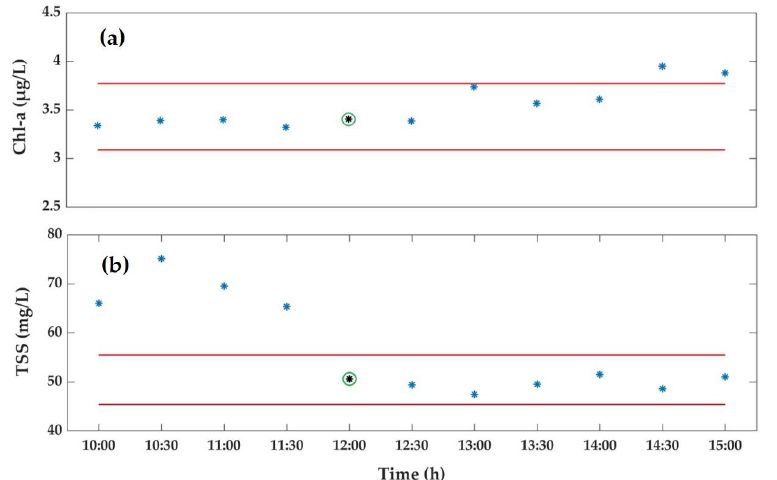
Figure 6. An example of in situ data screening using the multi-parameters forecasting model of ( a ) Chl-a and ( b ) TSS, where the black dots represent in situ Chl-a and TSS, and the blue dots refer to the predicted Chl-a and TSS based in situ Chl-a and TSS, respectively. In addition, the red lines represent the boundary of ±10% relative change, which are drawn based on in situ Chl-a and TSS measured at 12:00 (marked with green circles in the figure).